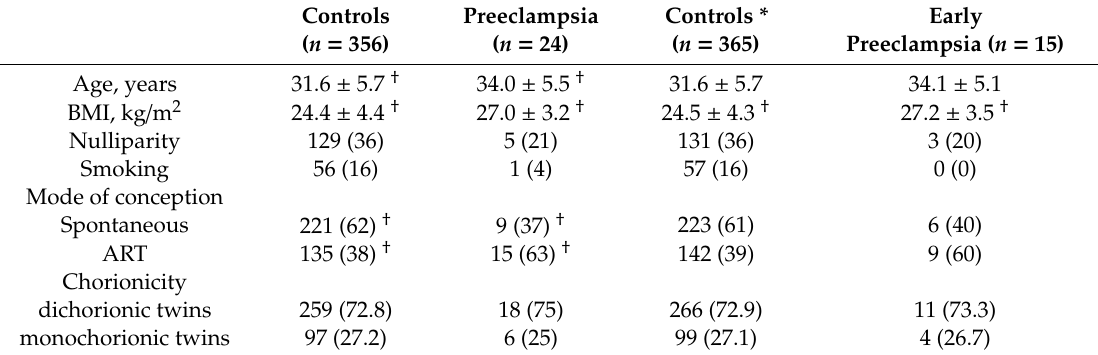
Table 1. Patients’ characteristics (Controls vs. Preeclampsia, Controls * vs. Early preeclampsia).